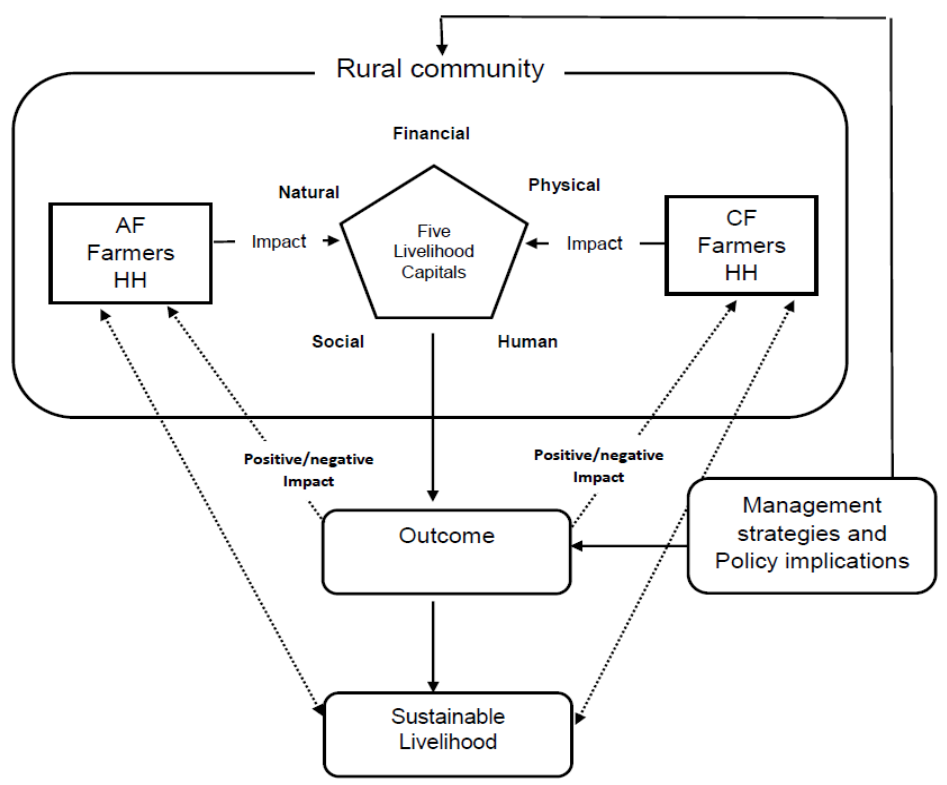
Figure 1. Conceptual framework of sustainable livelihood improvement through AF compared to